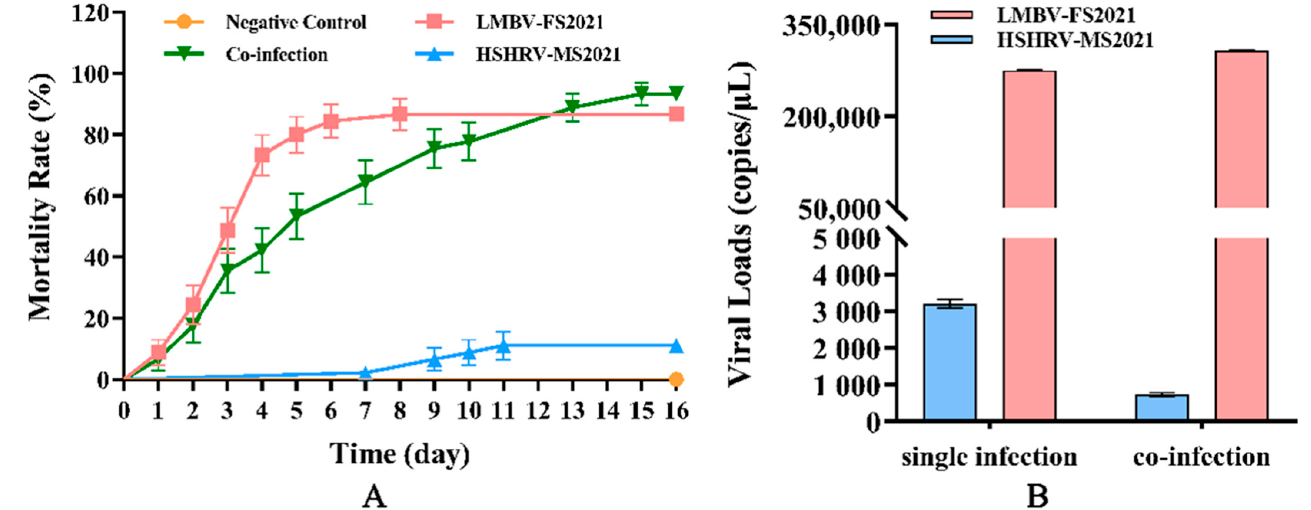
Figure 9. Cumulative mortality rate and viral loads of largemouth bass after challenge with viruses. ( A ) Cumulative mortality curves of largemouth bass in each group at 16 dpi, and ( B ) virus loads in largemouth bass at 16 dpi. The graph was produced by GraphPad Prism V8.0.2.263.